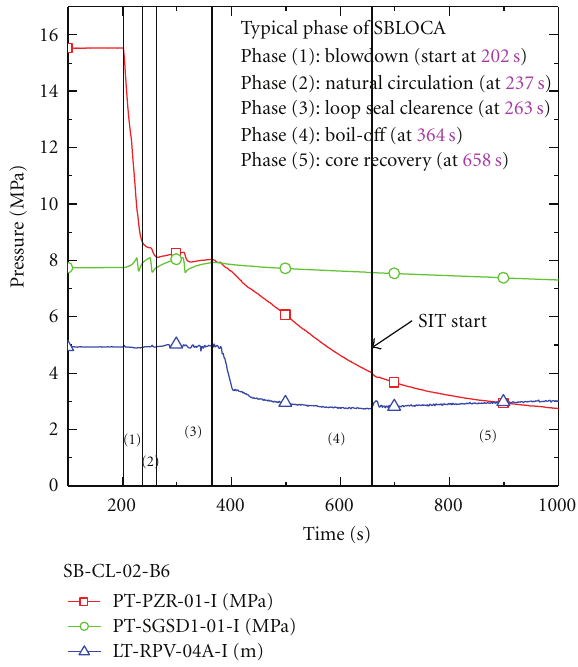
Figure 16: Identification of characteristic phases during the present SBLOCA test